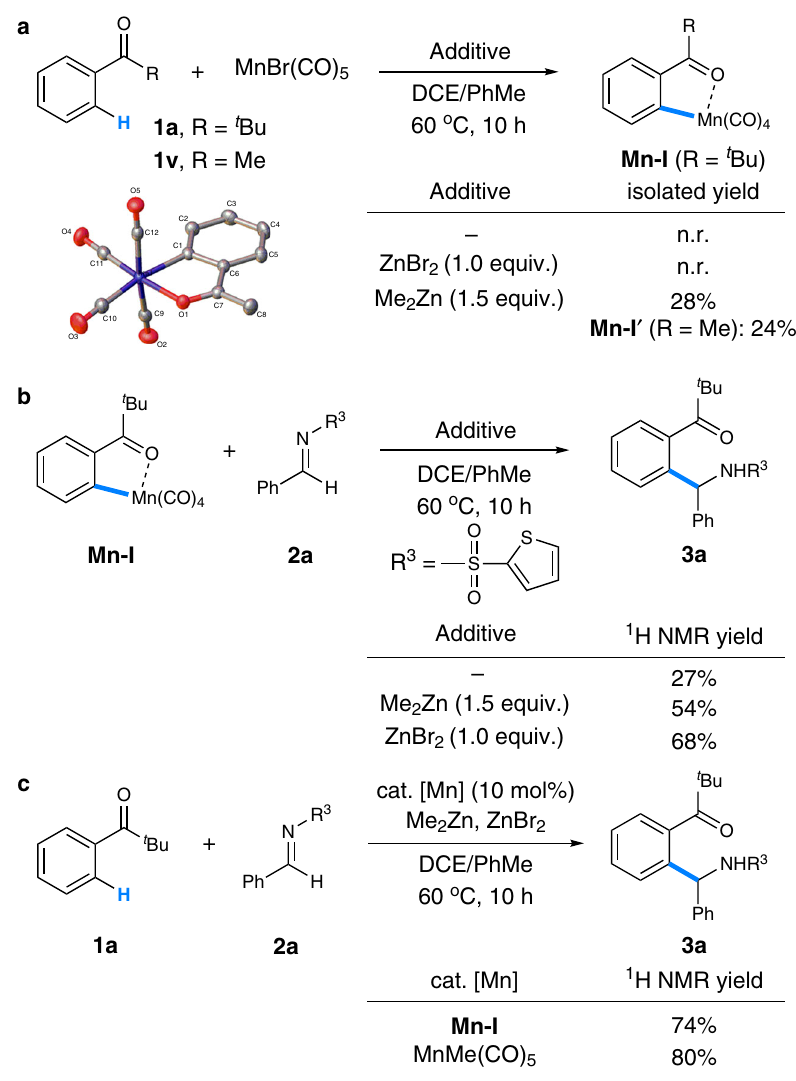
Fig. 8 Mechanistic experiments. a Isolation of key intermediates Mn-I and Mn-I ′ . b Stoichiometric reactions of Mn-I and imine 2a . c Reactions using Mn-I and MnMe(CO) 5 as a catalyst. DCE